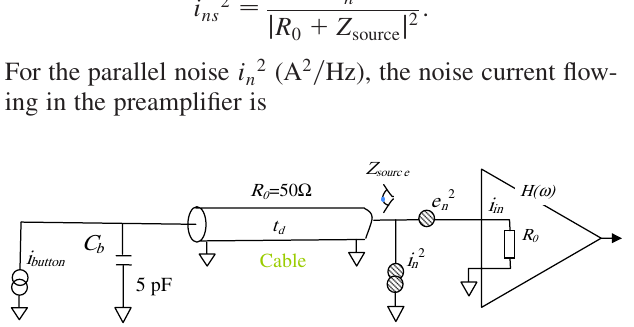
FIG. 11. (Color) SPICE AC analysis of the source impedance Z source versus frequency for (a) 30 m and (b) 30 cm lengths of the RG-58 cable. For a capacitive BPM pickup, it is better to implement long transmission lines to match the impedances.